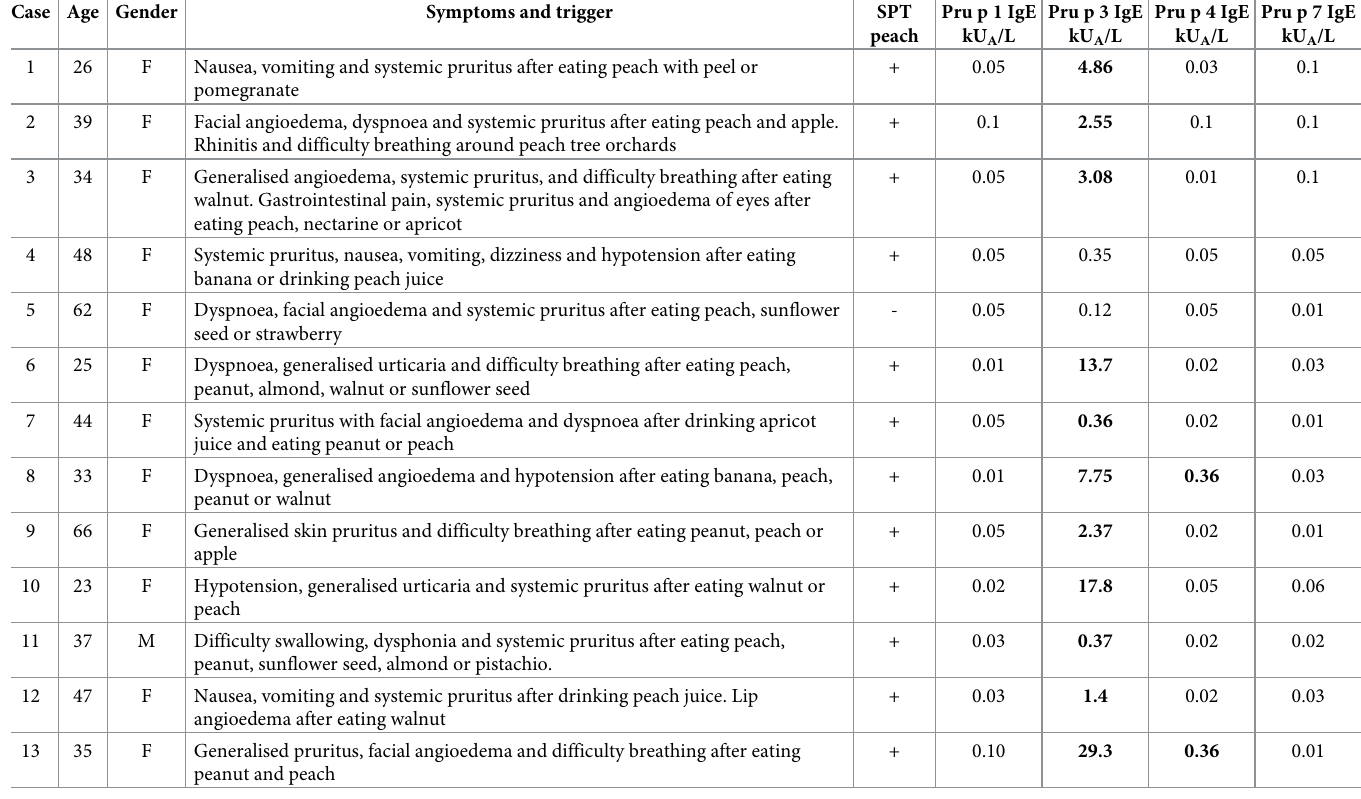
Table 3. Cases with anaphylaxis induced by peach. Case Age Gender Nausea, vomiting and systemic pruritus after eating peach with peel or pomegranate F Facial angioedema, dyspnoea and systemic pruritus after eating peach and apple. Rhinitis and difficulty breathing around peach tree orchards Generalised angioedema, systemic pruritus, and difficulty breathing after eating walnut. Gastrointestinal pain, systemic pruritus and angioedema of eyes after eating peach, nectarine or apricot F Systemic pruritus, nausea, vomiting, dizziness and hypotension after eating banana or drinking peach juice F Dyspnoea, facial angioedema and systemic pruritus after eating peach, sunflower seed or strawberry F Dyspnoea, generalised urticaria and difficulty breathing after eating peach, peanut, almond, walnut or sunflower seed Systemic pruritus with facial angioedema and dyspnoea after drinking apricot juice and eating peanut or peach F Dyspnoea, generalised angioedema and hypotension after eating banana, peach, peanut or walnut Generalised skin pruritus and difficulty breathing after eating peanut, peach or apple Hypotension, generalised urticaria and systemic pruritus after eating walnut or peach M Difficulty swallowing, dysphonia and systemic pruritus after eating peach, peanut, sunflower seed, almond or pistachio. Nausea, vomiting and systemic pruritus after drinking peach juice. Lip angioedema after eating walnut F Generalised pruritus, facial angioedema and difficulty breathing after eating peanut and peach F: female, M: male, SPT: skin prick